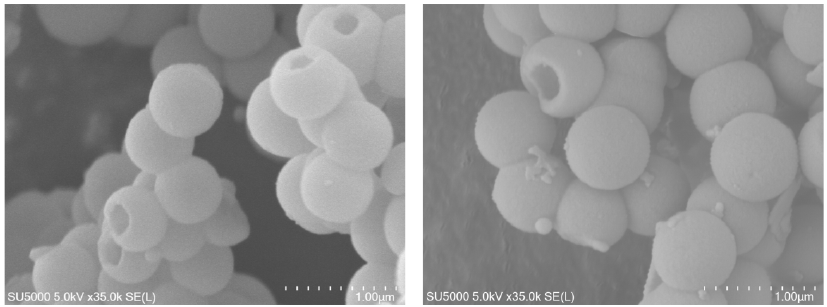
Figure 2 . Scanning Electron Microscopic (SEM) images of HMSS and M-NH 2 -CIT@CIT. The infrared spectrum of HMSS in Figure 3a shows a strong and wide absorption band at 1084 cm − 1 , which corresponds to the anti-symmetric stretching vibration of Si–O-Si. The band at 790 cm − 1 corresponds to the symmetric stretching vibration of the Si-O bond, and the band at 958 cm − 1 belongs to the bending vibration absorption band of Si-OH [34,35]. For the spectrum of M-NH 2 , except for the characteristic bands of HMSS, a new broad band appears at 3000 to 3600 cm − 1 corresponding to the loading of N-H [36]. However, the simultaneous presence of the antisymmetric vibrational band of O-H within 3000–3600 cm − 1 may mask the band of N-H. At the same time, the presence of characteristic bands corresponding to methylene C-H was observed at 2925 and 2854 cm − 1 in the spectra of M-NH 2 and M-NH 2 -CIT@CIT, which could equally indicate the successful modification of APTES on HMSS [37]. In the spectrum of CIT, the absorption bands at 1721 and 1683 cm − 1 are attributed to the stretching vibration of C = O, and the absorption bands at 1418 and 1233 cm − 1 are attributed to the coupling of OH in-plane bending